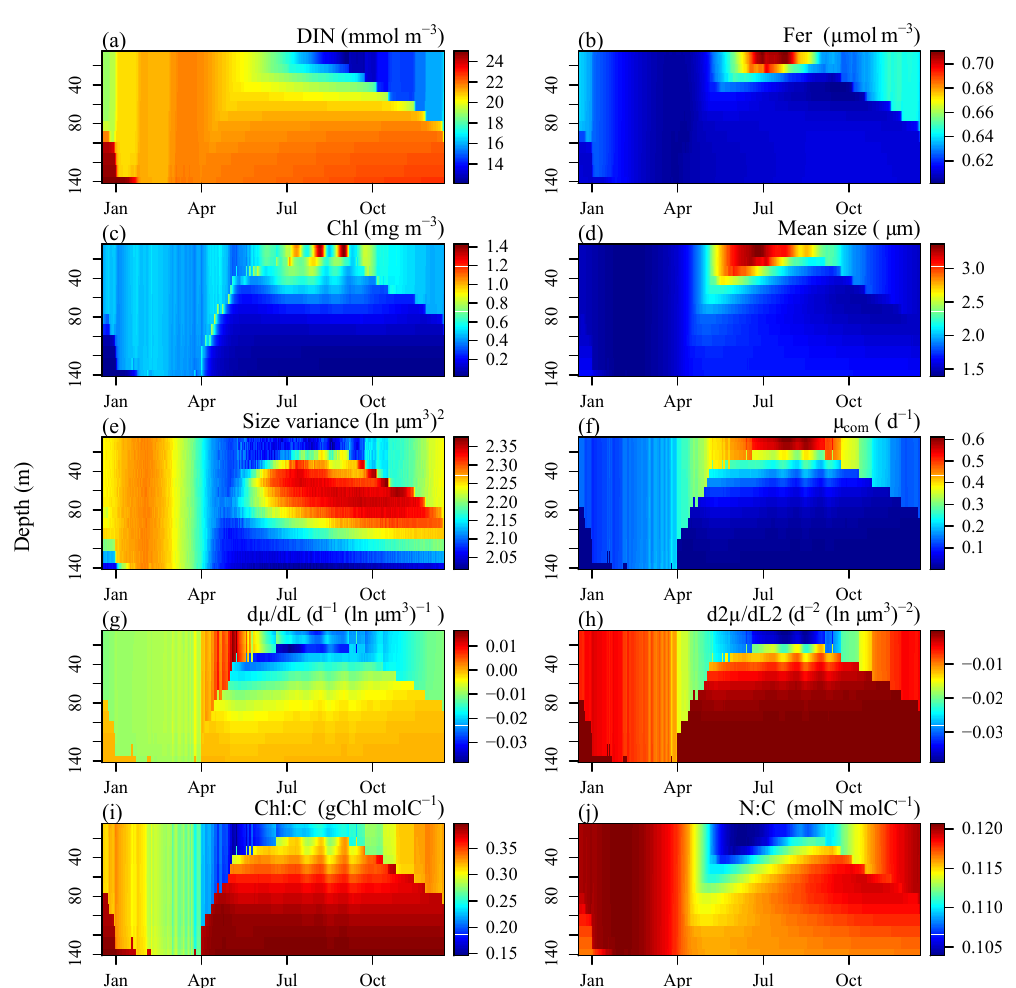
Figure 10. Modeled seasonal patterns at station K2: (a) DIN, (b) dissolved iron, (c) Chl a , (d) phytoplankton mean size, (e) size variance, (f) community-based specific growth rate ( µ com ) , (g) first derivative of phytoplankton growth rate against ln volume evaluated at mean size, (h) second derivative of phytoplankton growth rate evaluated at mean size, (i) chlorophyll-to-carbon ratios, and (j) nitrogen-to-carbon